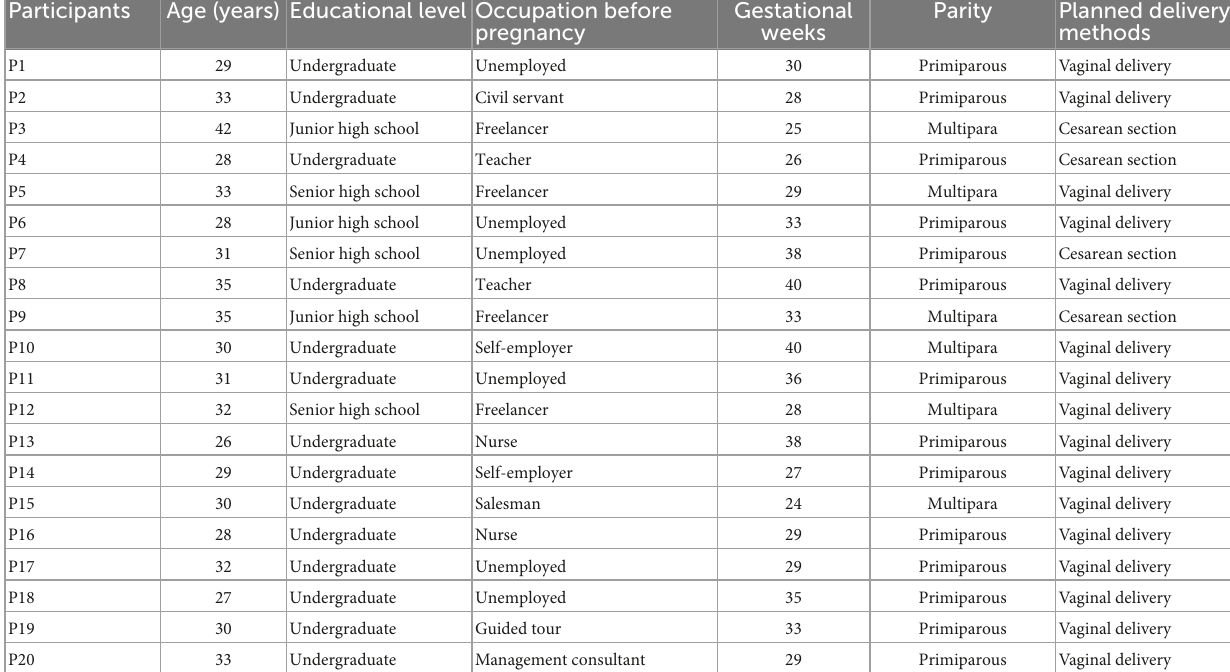
TABLE 2 Interview information and characteristics of participants.